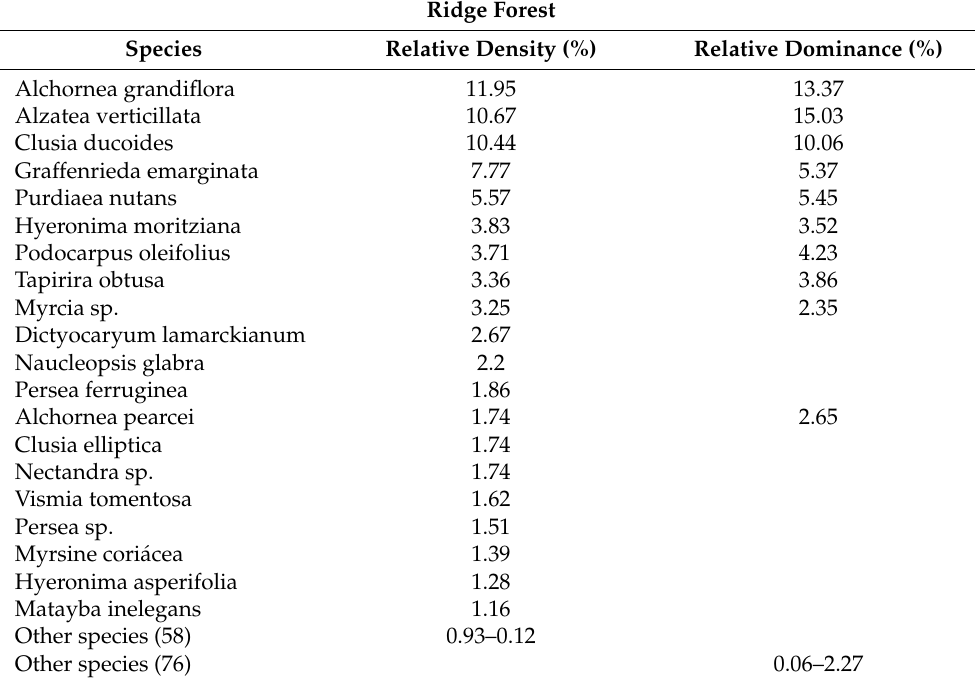
Table 5. Values of relative diversity in both forest